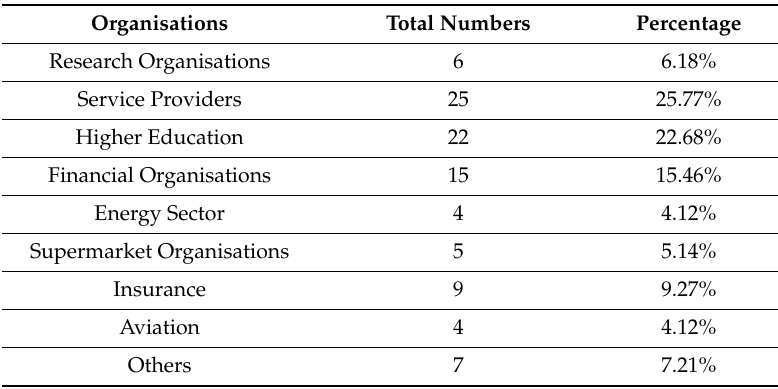
Table 1. Survey respondents in percentage